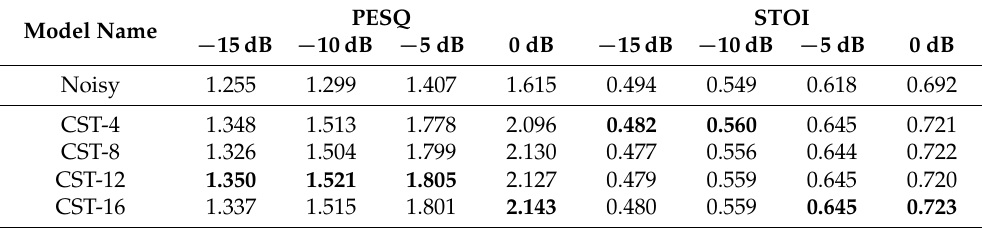
Table 6. Effect of different layers in the VCTK test